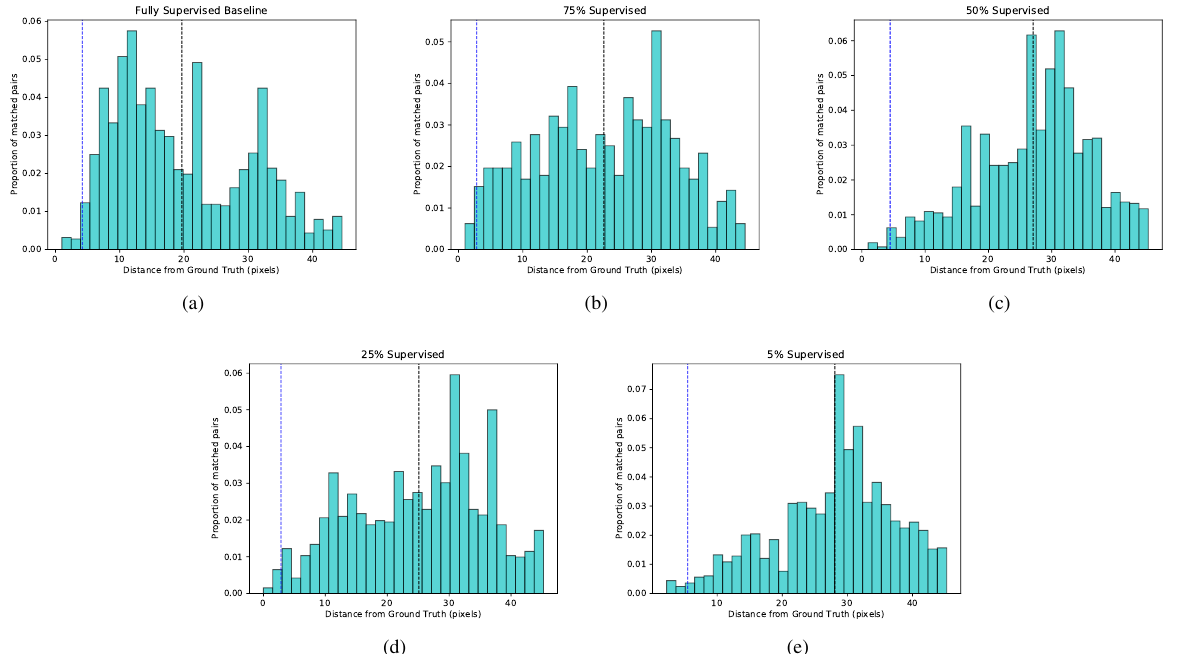
Figure 4: Histograms reflecting the precision of the determined matched point when compared to the ground truth location for varying degrees of supervision. The dashed black line represents the mean matching distance while the dashed blue line represents the 1- percentile matching